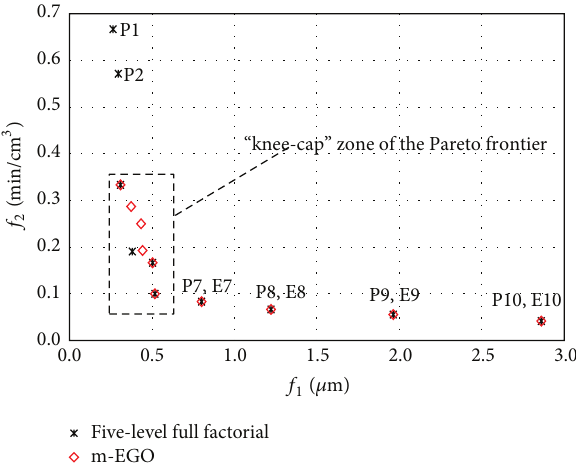
Figure 5: Comparison of obtained Pareto frontiers.